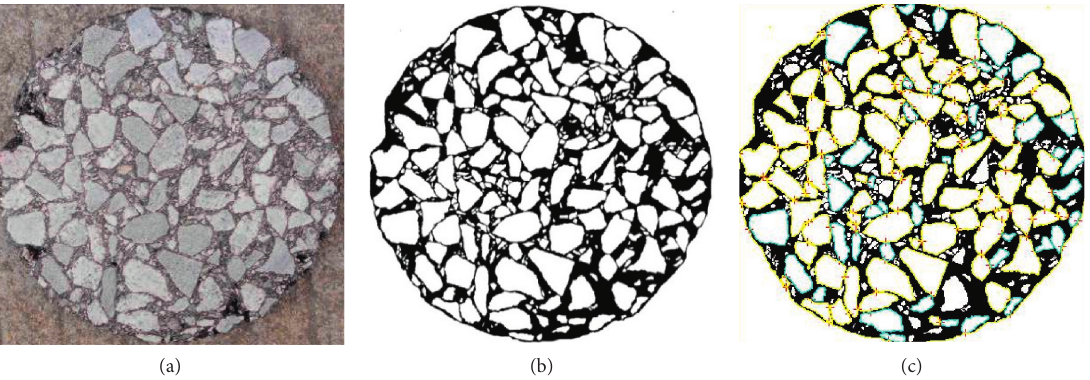
Figure 5: Image processing and contact analysis: (a) section image of HMA; (b) binary image; (c) contact analysis